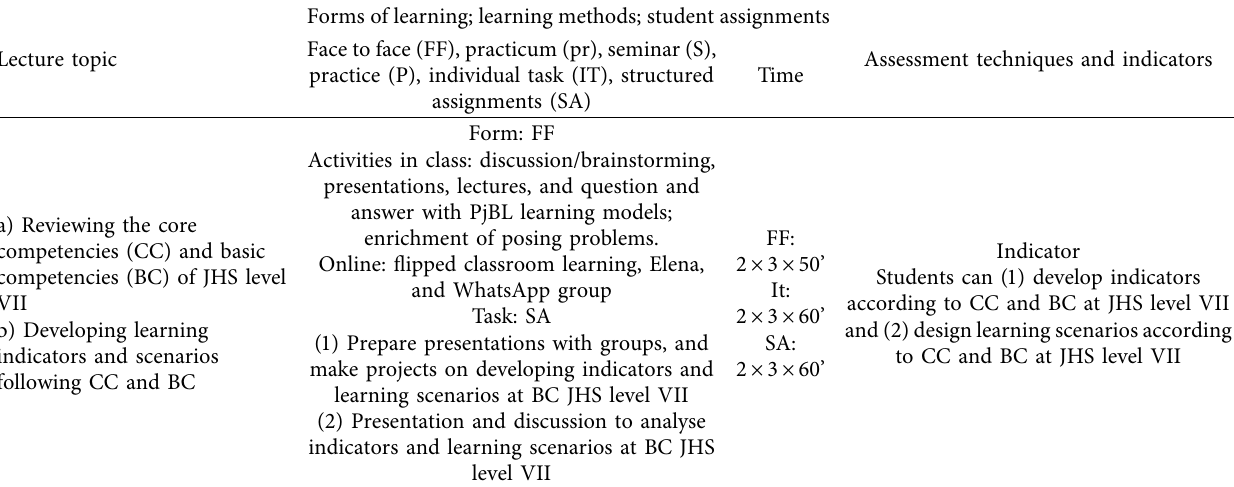
Table 1: Course A lecture SLP snippet.